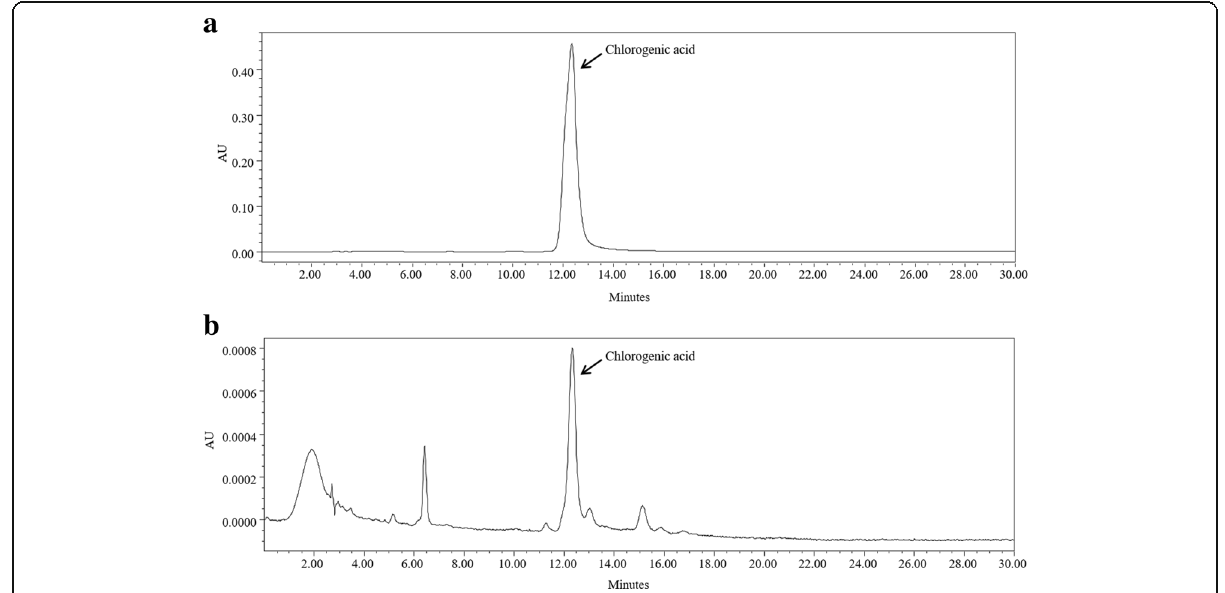
Fig. 1 HPLC Chromatograms of the a Chlorogenic acid and b